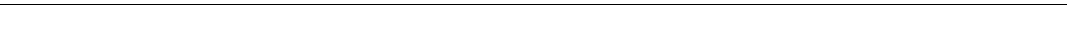
Table 1. Estimated Optimal Amounts (by Weight) of Specific Foods Required by the Toronto Population in 2006 using 2006 Food Disappearance Data (unadjusted for losses) a (adapted from Desjardins et al.,